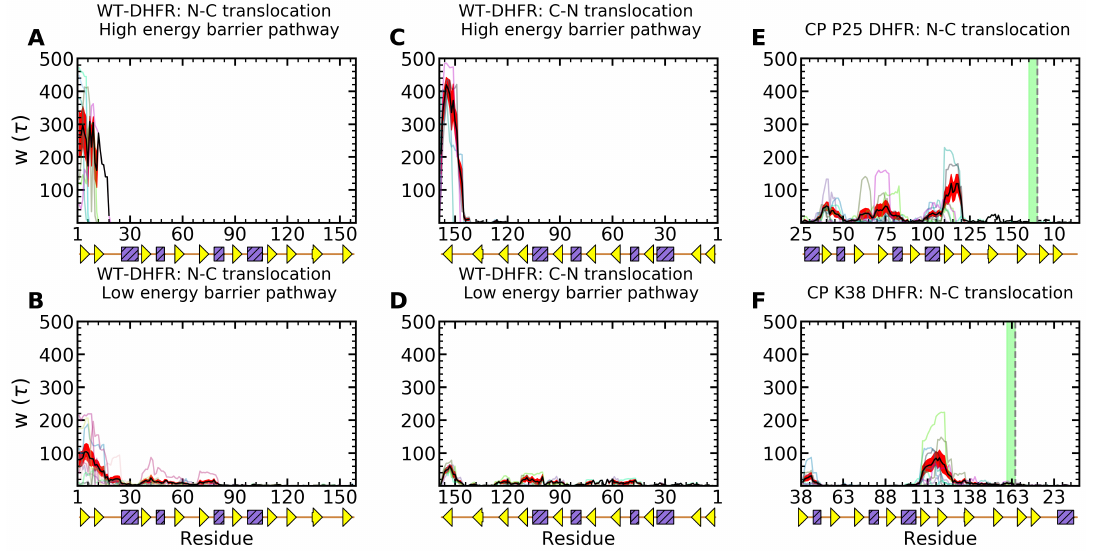
Figure 10. Translocation hindrance of DHFR variants. The waiting time per residue of the wild-type DHFR is shown in translocation in the ( A , B ) N-C direction in the ( A ) high- and ( B ) low-energy barrier pathways, in the ( C , D ) C-N direction. ( E , F ) Same as in ( A ) for the circular permutant DHFR variants ( E ) P25 and ( F ) K38 (the wild-type N- and C-terminal sequence positions are indicated by using dashes and a green line, respectively). Traces for individual trajectories are shown by using thin curves and averaged values by using thick black curves. Standard errors are shown by using red